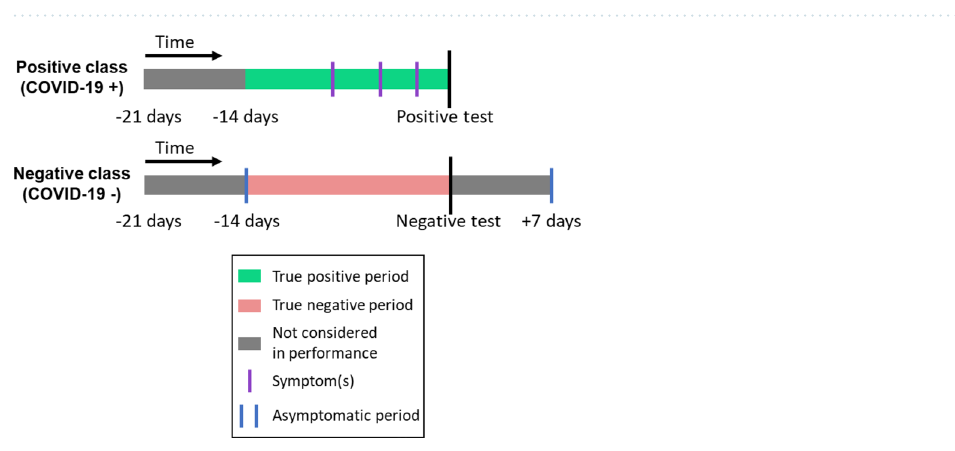
Figure 3. The admin UI allows site coordinators to monitor the infection risk at a site level. Selecting an individual on the scatter plot shows the infection score trend for that user.